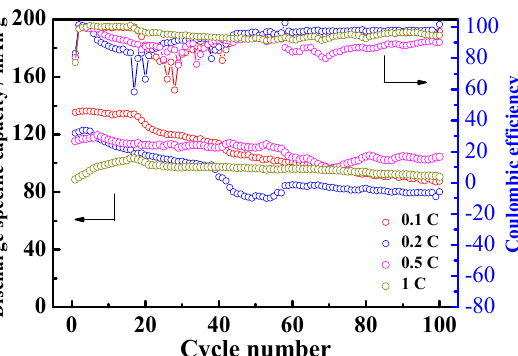
Figure 6. Cycling stabilities of LIBs with TLPEC electrolyte under different charge and discharge current densities at 25 °C.